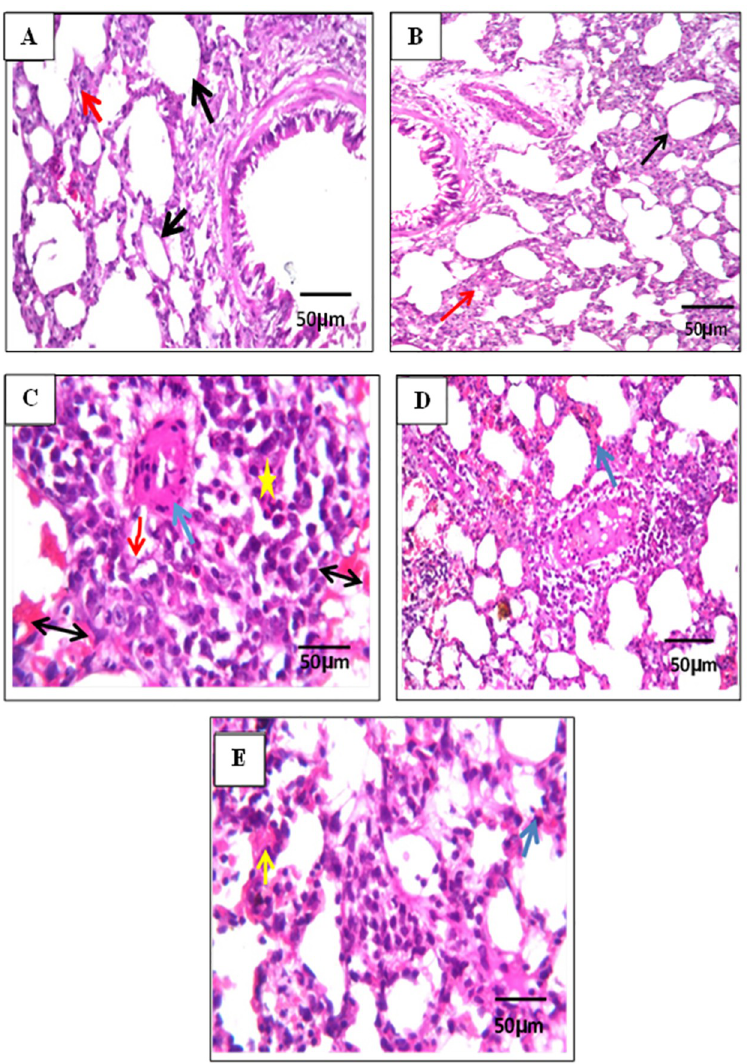
Fig 9. Effect of β -carotene on lung histopathology. Representative light microphotographs from the lung. There were no histopathological changes and the regular histological pattern of the blood vessels (black arrow) with normal alveolar septa (red arrow) and the surrounding air alveoli in the parenchyma were recorded in the control group (A). In the β -carotene 40 mg/ kg control group there were no histopathological changes and the regular histological pattern of the blood vessels (black arrow) with normal alveolar septa (green arrow) (B). However, in CP-group, there are thickened interalveolar septa (star), narrow alveoli (red arrow), and diffuse hemorrhages (blue arrow) were impacted the air associated with emphysema of some other air alveoli in some lobules of the parenchyma. There was multiple focal inflammatory cell aggregation in the parenchyma. The main inflammatory cells aggregation in the parenchyma were macrophages, lymphocytes, and eosinophils (arrow with two heads) (C). In β -carotene 20 mg/ kg groups, focal hemorrhages were detected in the air alveoli (blue arrow), associated with perivascular inflammatory cell infiltration (red arrow), and emphysema in the air alveoli (D). In β -carotene 40 mg/ kg groups, there was congestion in the blood vessels (blue arrow) of the parenchyma associated with mild inflammatory cells infiltration (yellow arrow) mainly lymphocytes and macrophages in between the ail alveoli (E) (H&E X 200). The administration of natural β -carotene, in the present study, protected mice against CP- induced ALI and lung inflammation through the activation of the SIRT1 and PPAR γ signaling pathway. SIRT1 expression leads to the down-regulation of antioxidant genes and stimulation of inflammation via modulating the FOXO1/NF- κβ signaling pathway [45]. The administration